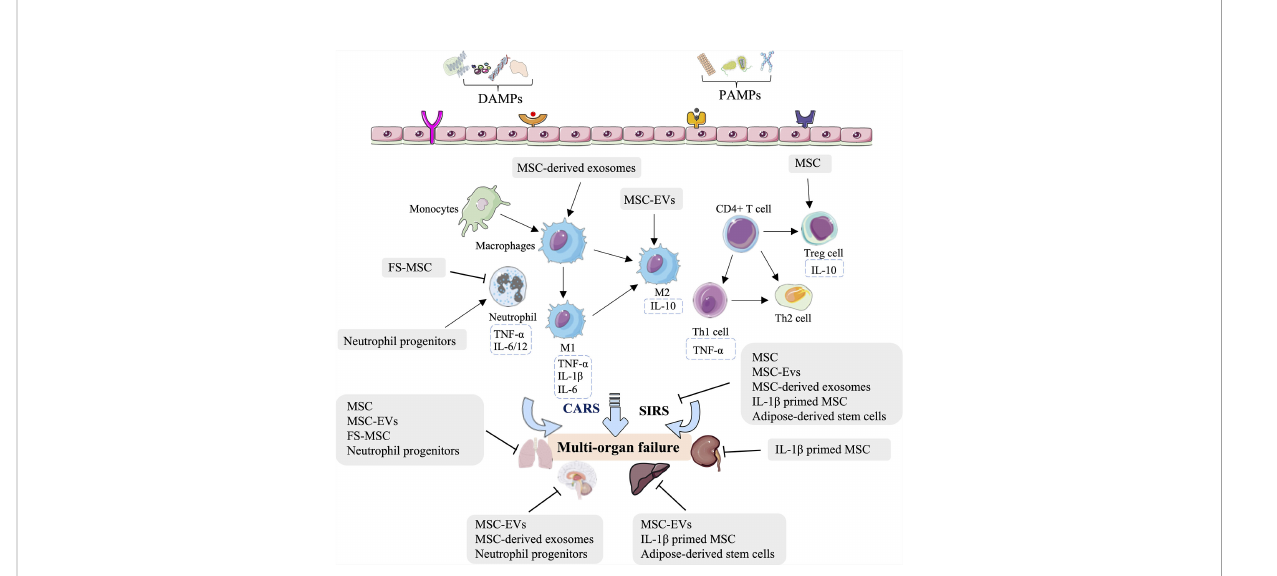
FIGURE 2 Overview of the immune therapeutic strategies of stem cells in hemorrhagic shock. The mesenchymal stem cell (MSC), MSC-derived extracellular vesicles (MSC-EVs), MSC-derived soluble factors (FS-MSC), MSC-derived exosomes, adipose-derived stem cells, and neutrophil progenitors can relieve the lung, neurologic, kidney, and liver injury by regulating neutrophil in fi ltration, increasing the Treg population, mediating M2-type macrophage polarization and consequent immunosuppression, and inactivation of in fl ammatory chemokine and